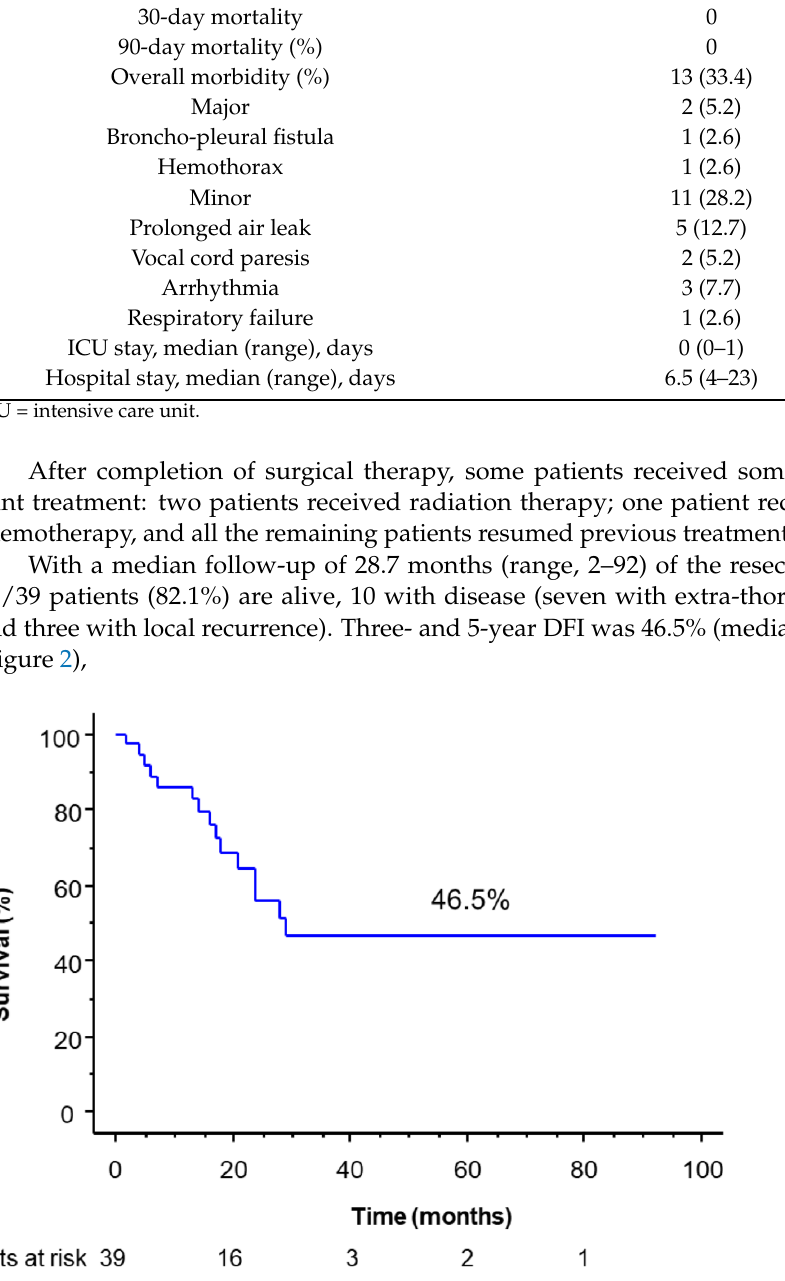
Figure 3. Overall survival of the operated patients. 4. Discussion For a long time, sequential or concurrent chemo ‐ radiotherapy has been considered the standard treatment for advanced NSCLC with a dismal prognosis. Standard chemo ‐ therapy with platinum ‐ based combinations have been largely used, demonstrating an in ‐ crease in the overall survival of 8–10 months [1,8]. EGFR ‐ TKI has been proven to be able to convert advanced NSCLC to an operable status after neoadjuvant treatment among patients harboring EGFR mutations, including T790M, L858R, and exon ‐ 19 deletion. EGFR ‐ TKI has shown to be extremely effective in more than 70% of advanced NSCLC with EGFR mutations [15]. Several case reports on patients with advanced stage undergo ‐